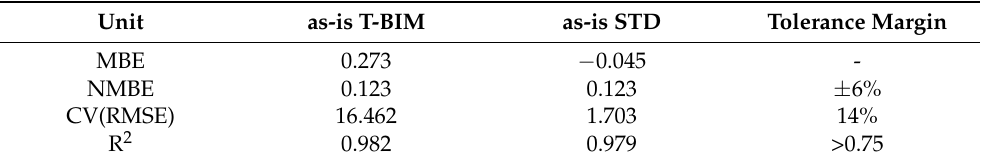
Table 6. Statistical simulation values for the as-is STD and the as-is T-BIM calibrated models, in relation to the monitoring data from Room W1. Unit as-is T-BIM as-is STD MBE